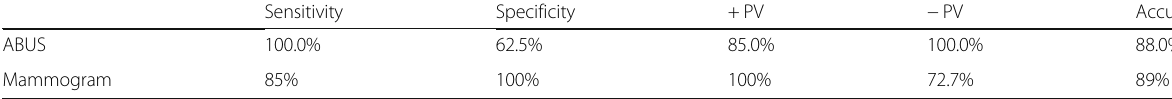
Table 7 Comparison of accuracy measures of ABUS and mammogram than ratio of sensitivity and specificity